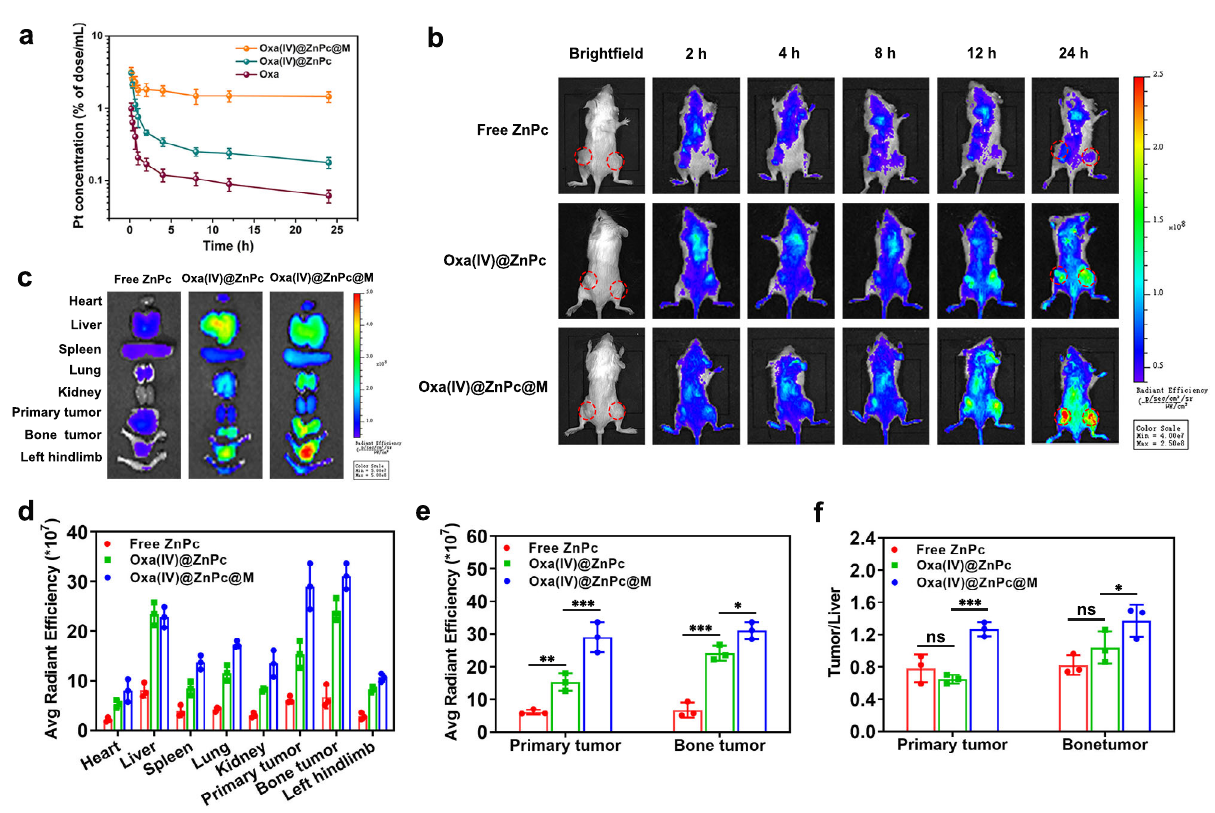
Fig. 5 In vivo pharmacokinetics and tumor distribution. a Pharmacokinetics pro fi les in SD rats after intravenous injection of free Oxa, Oxa(IV)@ZnPc and Oxa (IV)@ZnPc@M ( n = 3 individual animals). b Fluorescence imaging of free ZnPc, Oxa(IV)@ZnPc and Oxa(IV)@ZnPc@M distribution in primary tumors and bone metastatic tumors in 4T1 tumor-bearing mice. Red circle represents tumor area. c Ex vivo fl uorescence imaging of the excised organs and tumors at 24h post- injection. d Quantitative fl uorescence intensity of the excised organs and tumors at 24h post-injection ( n = 3 individual animals). e Quanti fi cation fl uorescence intensity of primary tumors and bone metastatic tumors (** p = 0.0042, *** p = 0.0002, *** p <0.0001, * p = 0.0259). f Quanti fi cation fl uorescence intensity of tumor: liver at 24h post-injection (*** p = 0.0007, * p = 0.0461). Red circle represents tumor area. All data were presented as mean±SD. Statistical signi fi cance was calculated via two-way ANOVA with a Tukey ’ s test. “ ns ” represents not signi fi cant, and * p <0.05, ** p <0.01, *** p <0.001. Source data are provided as a Source data fi